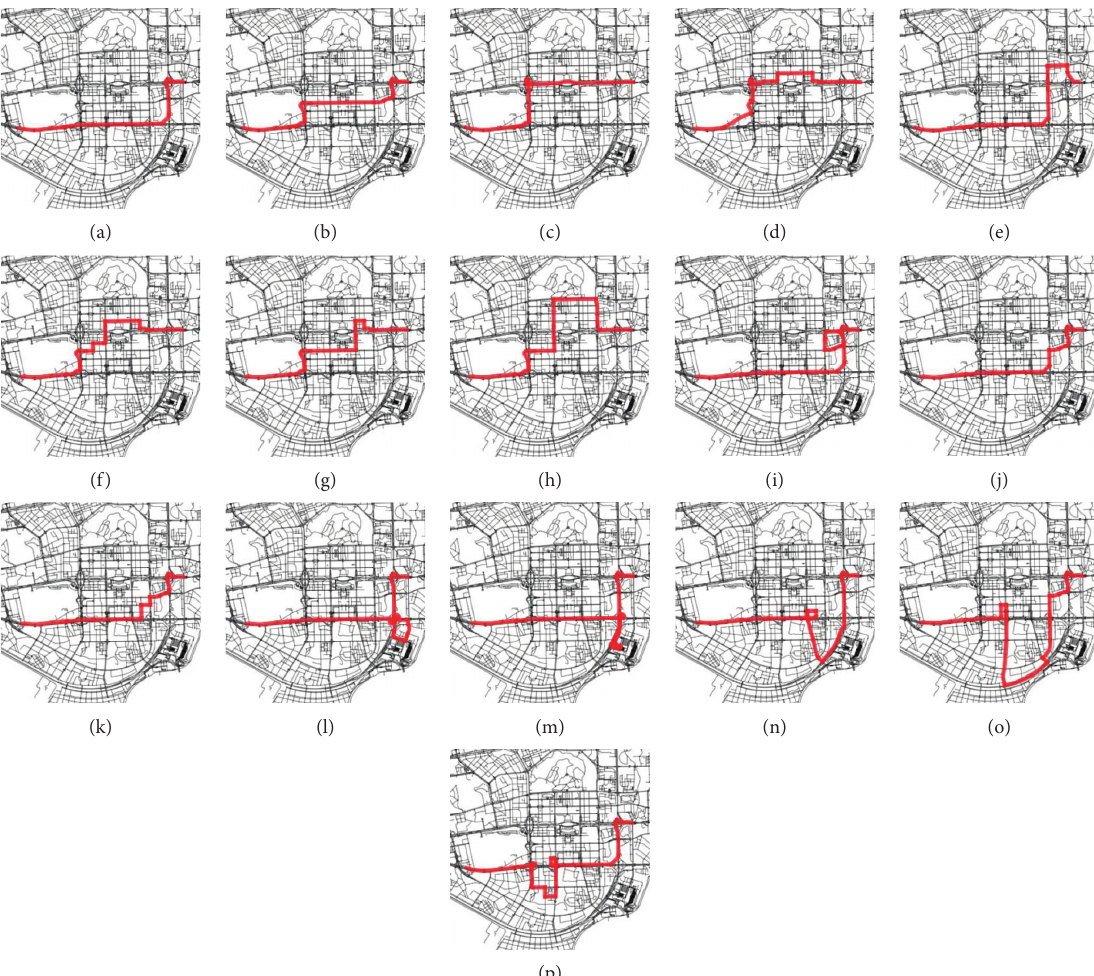
Figure 10: (a–p) Generated candidate paths between the example sensor pair: ( F